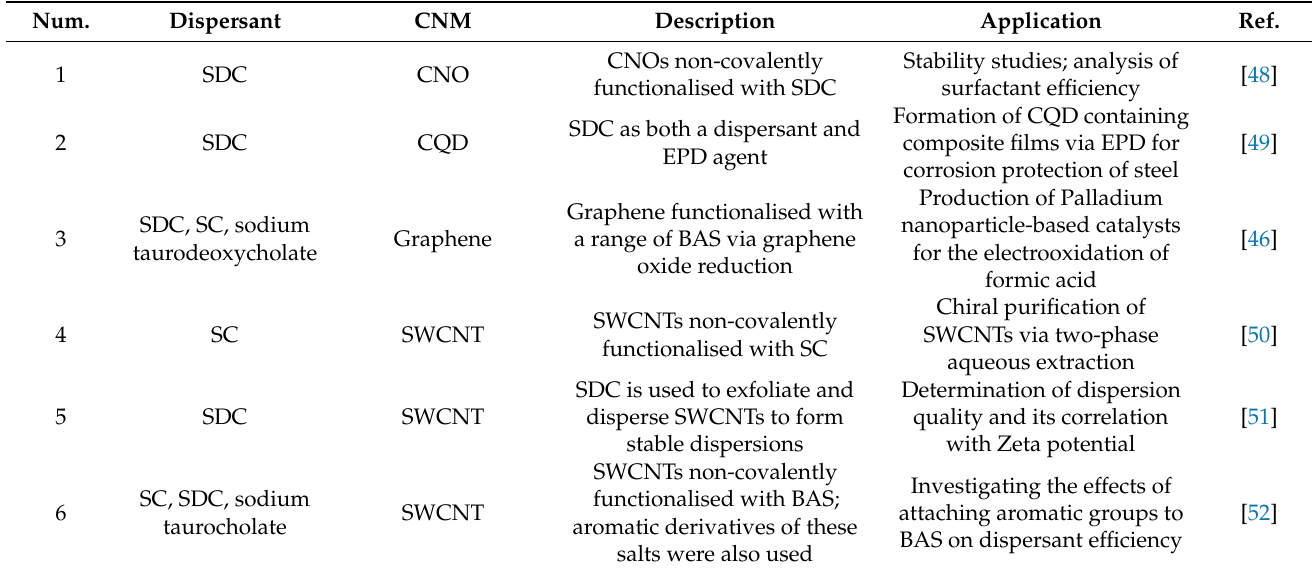
Table 3. BAS-based CNM